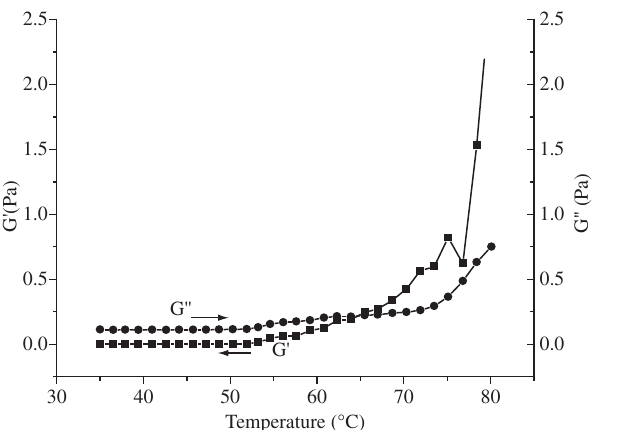
Figure 1. Rheograms showing the elastic (G’) and viscous (G”) moduli of the suspension with 5 wt. (%) albumin, as a function of temperature.